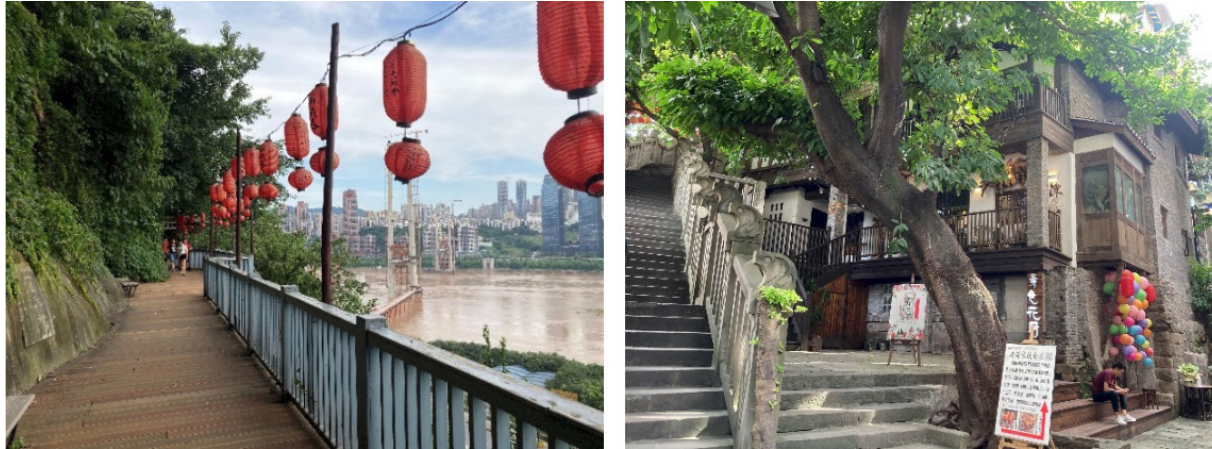
Figure 10. Shancheng Alley: The plank road section (left) and the section with renovated buildings (right). Urban Planning, 2022, Volume 7, Issue 4, Pages